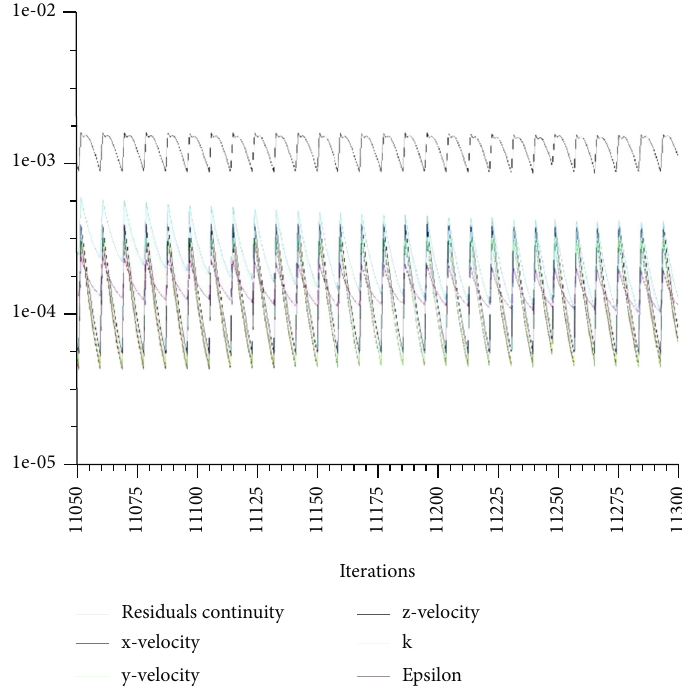
Figure 3: Residuals for 3D mesh with approximately 1 million cells.